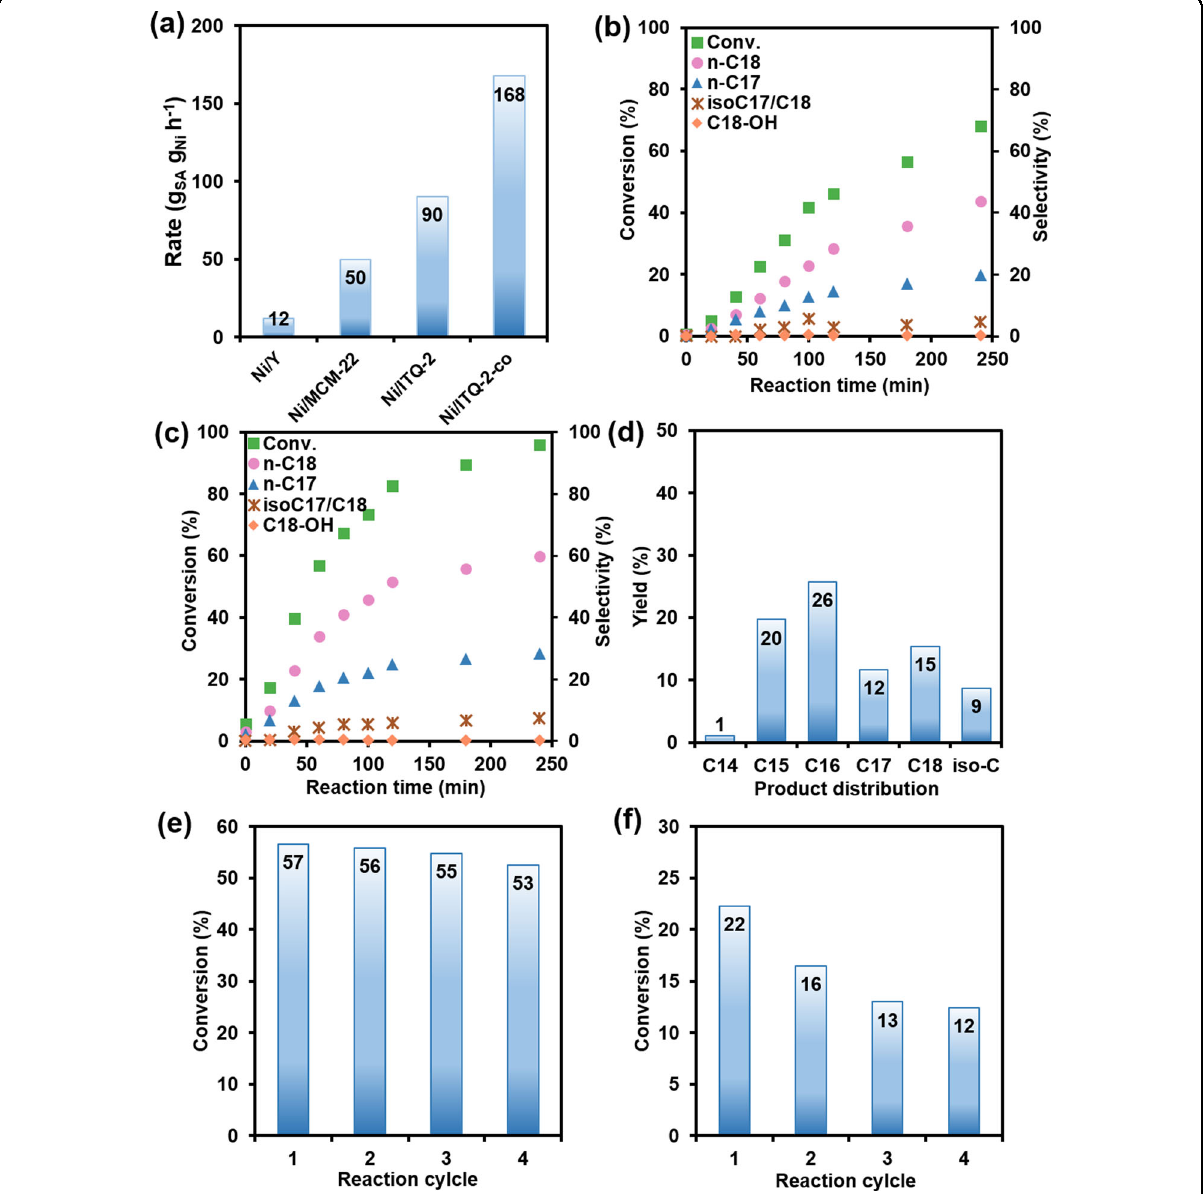
Fig. 4 Catalytic performance of prepared Ni/zeolite catalysts for deoxygenation reactions of SA. Comparison of normalized rates for SA conversion over the prepared Ni/zeolites ( a ); Time-dependent conversions of SA and product selectivities seen with Ni/ITQ-2 ( b ) and Ni/ITQ-2-co ( c ). Product compositions after the deoxygenation of palm oil over Ni/ITQ-2-co ( d ). Reaction conditions: 260 °C, 4 MPa H 2 , time = 4 h. stirring speed = 1000 rpm, stearic acid/catalyst = 10 by mass. The conversion of SA and the selectivity for each product were calculated with Equations S2 and S3. The yield of each product was calculated with Equation S4; recycling tests of Ni/ITQ-2-co ( e ) and Ni/ITQ-2 ( f ) for the deoxygenation reaction of SA. Reaction conditions: 260 °C, 4 MPa H 2 , time = 1 h, stirring speed = 1000 rpm, stearic acid/catalyst = 10 by